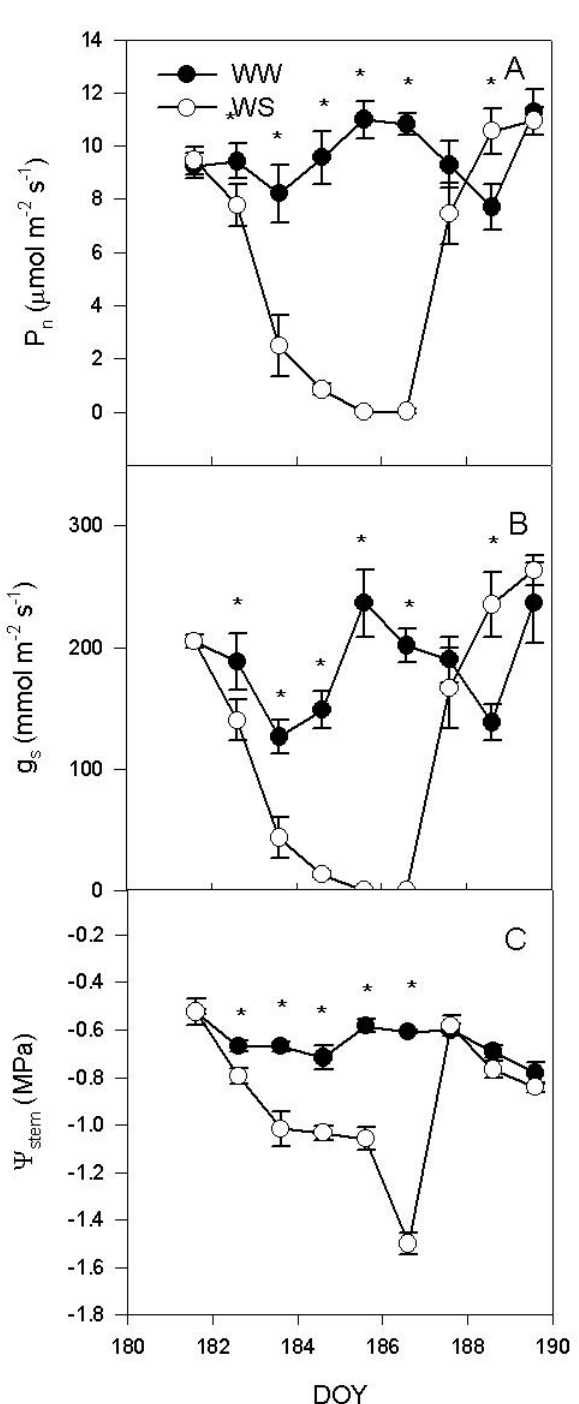
Figure 1. ( A ) net photosynthesis (P n ), ( B ) stomatal conductance (g s ), and ( C ) stem water potential at midday (Ψ stem ) recorded on mature leaves of well-watered (WW) and water stress vines (WS) during the experiment. Each point is the mean of six vines ±SE. Points marked by asterisk are different per p < 0.05 ( t -test). Upon re-watering (DOY 187), P n and g s were similar between WS and WW vines except at DOY 188 when the WS treatment had higher P n and g s than the WW vines. Ψ stem in WS vines decreased during water stress up to − 1.5 ± 0.04 MPa and reached values like